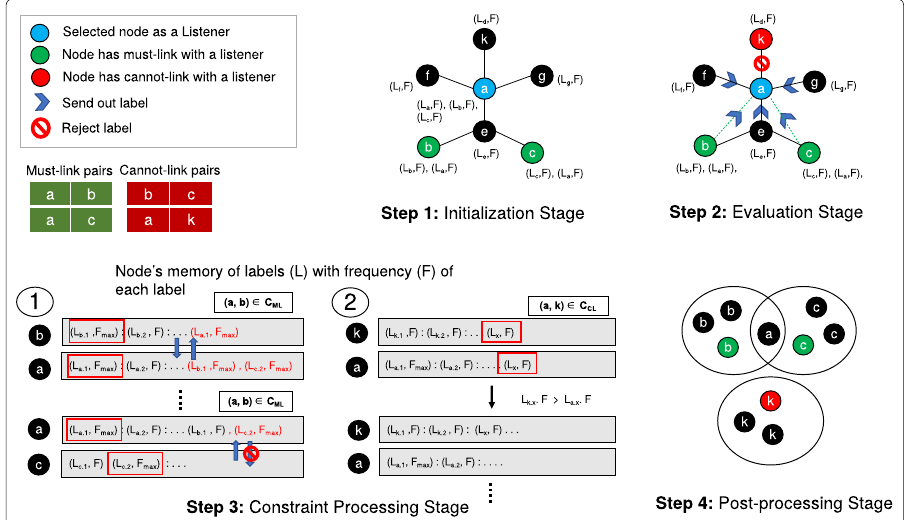
Fig. 3 An illustration of Steps 1-4 involved in the PC-SLPA